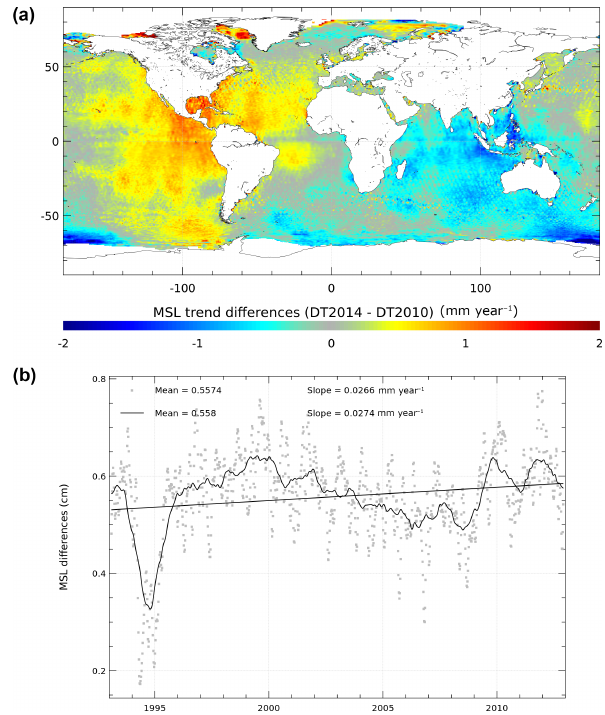
Figure 15. (a) Map of the differences of the local MSL trend esti- mated from the DT2014 and DT2010 gridded SLA products. MSL estimated over the [1993–2012] period. (b) Temporal evolution of the differences of the global MSL estimated from DT2014 and